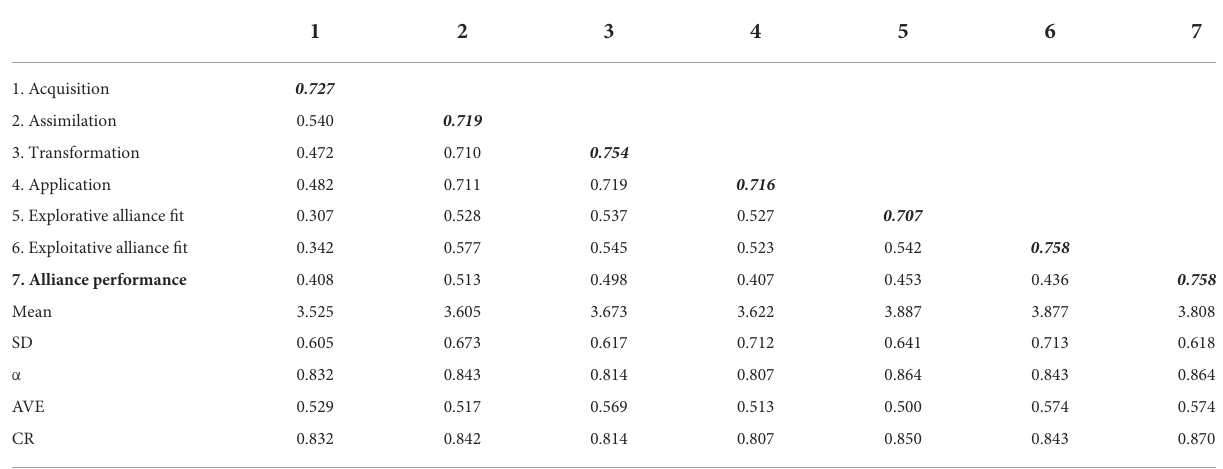
TABLE 2 Measurement of